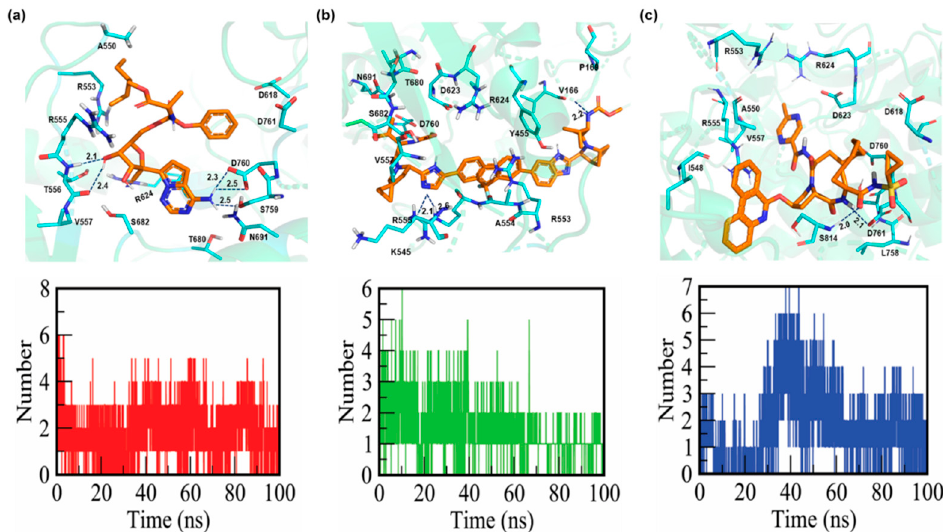
Figure 2. Binding mode and hydrogen bonds of remdesivir, ledipasvir, and paritaprevir with RdRp. Detailed interactions occurring within 4 Å of the ligands are shown. RdRp is lime-green (transparent). Ligands ledipasvir, remdesivir, and paritaprevir are presented as orange stick models. ( a ) Interactions of remdesivir and the number of hydrogen bonds with important residues in the ligand-binding pocket of RdRp. ( b ) Binding mode of ledipasvir and the number of hydrogen bonds with RdRp. ( c ) Binding mode of paritaprevir and the number of hydrogen bonds with RdRp.